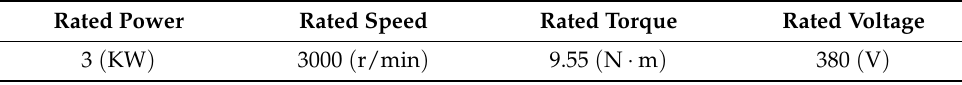
Figure 4. Test bench for the control system of the electric dynamic load simulator. Table 1. The main indicators of permanent magnet synchronous motor (PMSM) loading motor.